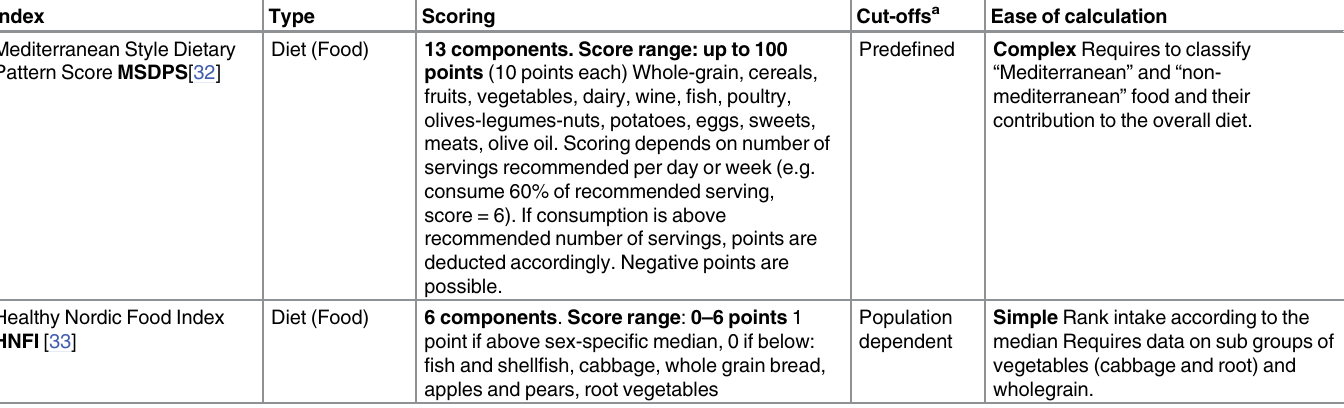
Prede fi ned Complex Requires to classify “ Mediterranean ” and “ non- mediterranean ” food and their contribution to the overall diet. Simple Rank intake according to the Population dependent median Requires data on sub groups of vegetables (cabbage and root) and